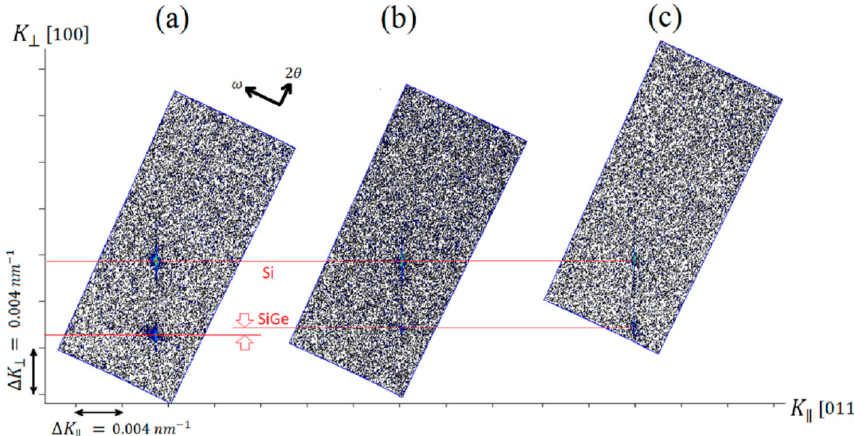
Figure 9. high-resolution reciprocal lattice maps (HRRLMs) around (113) reflection from 22 nm metal oxide field effect transistors (MOSFETs) with Si 0.65 Ge 0.35 in S/D areas as follows ( a ) an intrinsic layer and ( b ) B-doped layer ( c ) as previous sample but with a SiGe sacrificial layer which was consumed in NiSiGe cap layer. Reproduced with permission from [54]. Copyright Journal of Applied Physics, 2013.